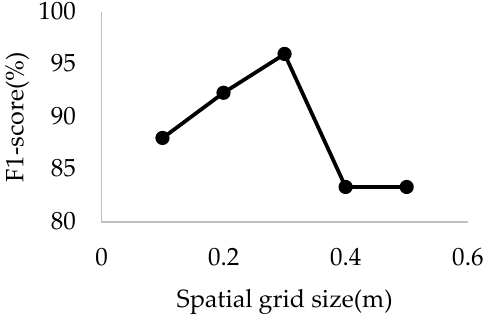
Figure 14. F1-score values for different spatial grid sizes.